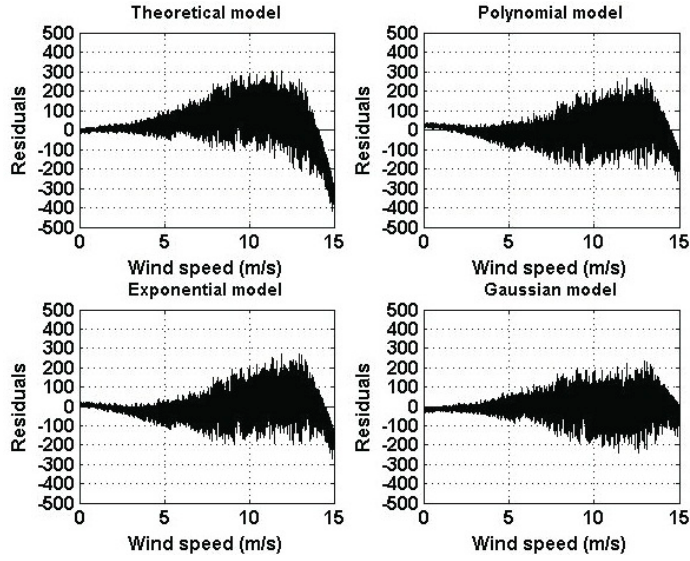
Figure 6. Residuals of the estimated models of Table 1.